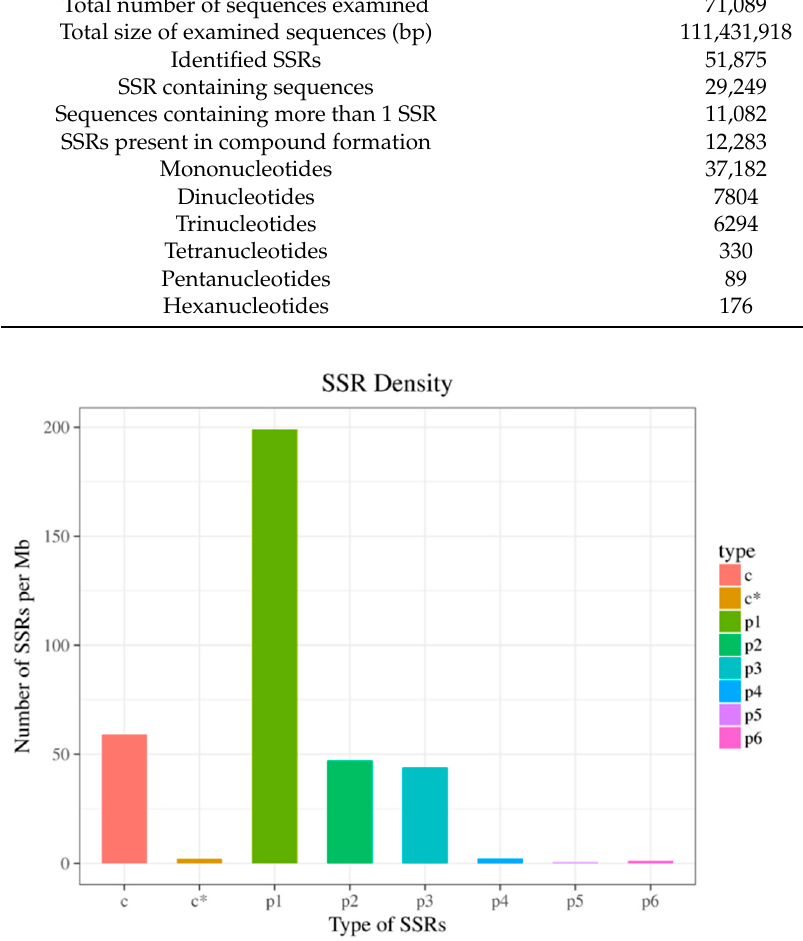
Figure 6. SSR density distribution. The abscissa is the SSR type, and the ordinate is the number of SSRs of the corresponding type in each Mb of sequence.